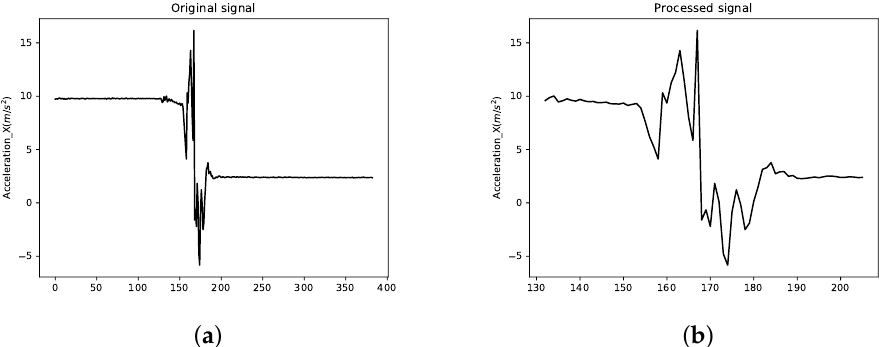
Figure 1. Comparison before and after window interception: ( a ) original signal; ( b ) processed